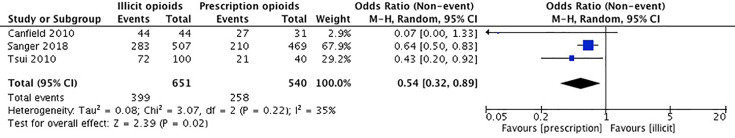
Forest Plot for Cannabis Use.